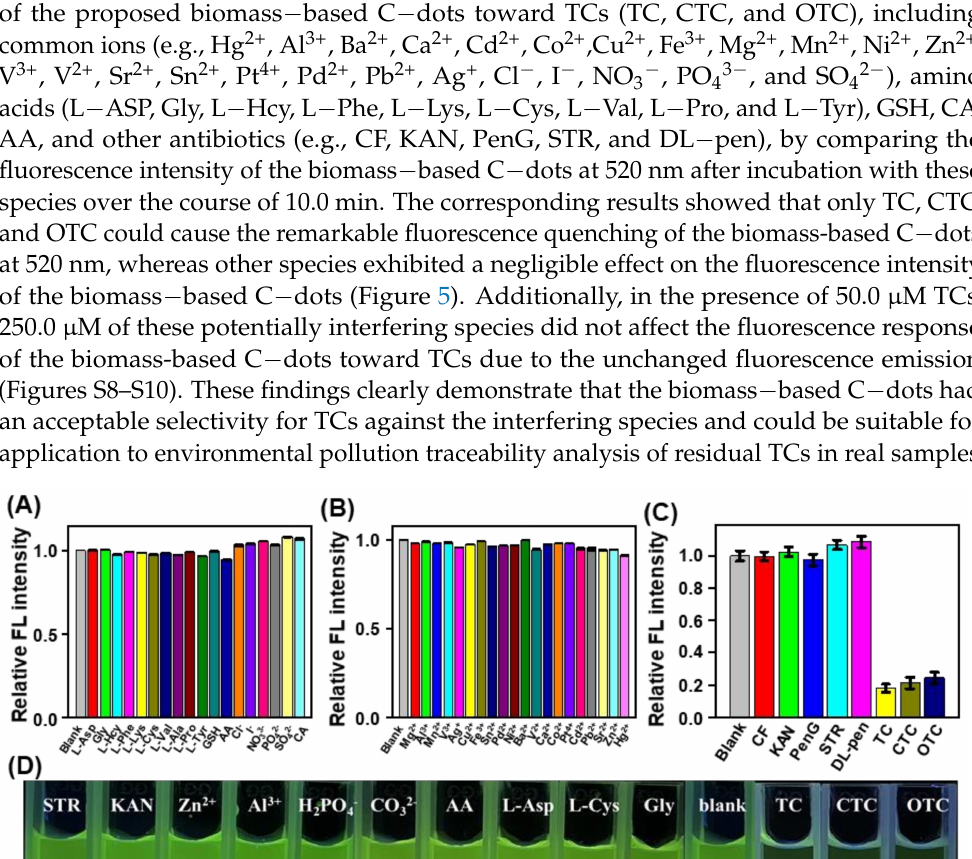
( D ) C − dots florescence intensity plot at 520 nm versus CTC concentration, as shown in Figure 4C. Inset: linearity of the C − dots florescence intensity at 520 nm versus CTC concentration in the range of 0.0 − 100.0 µ M. Conditions: pH = 4.0; reaction time, 10.0 min; temperature, 50.0 ◦ C. ( E ) Fluorescence emission spectra of the biomass − based C − dots (10.0 µ g/mL) incubated with various concentrations of OTC in the range of 0.0 to 500.0 µ M. ( F ) C-dot florescence intensity plot at 520 nm versus OTC concentration, as shown in Figure 4E. Inset: linearity of the C − dots florescence intensity at 520 nm versus OTC concentration in the range of 0.0 − 200.0 µ M. Conditions: pH = 4.0; reaction time, 10.0 min; temperature, 20.0 ◦ C.